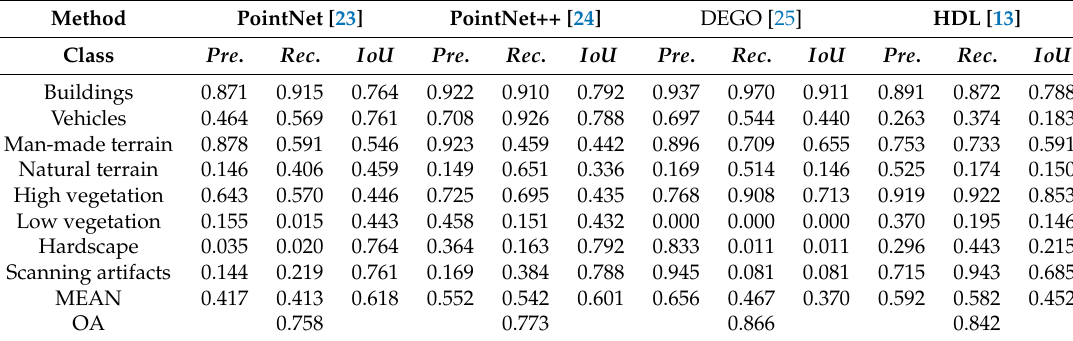
Table 3. Comparision of semantic labeling results using the annotated TUM-City-Campus MLS dataset with different